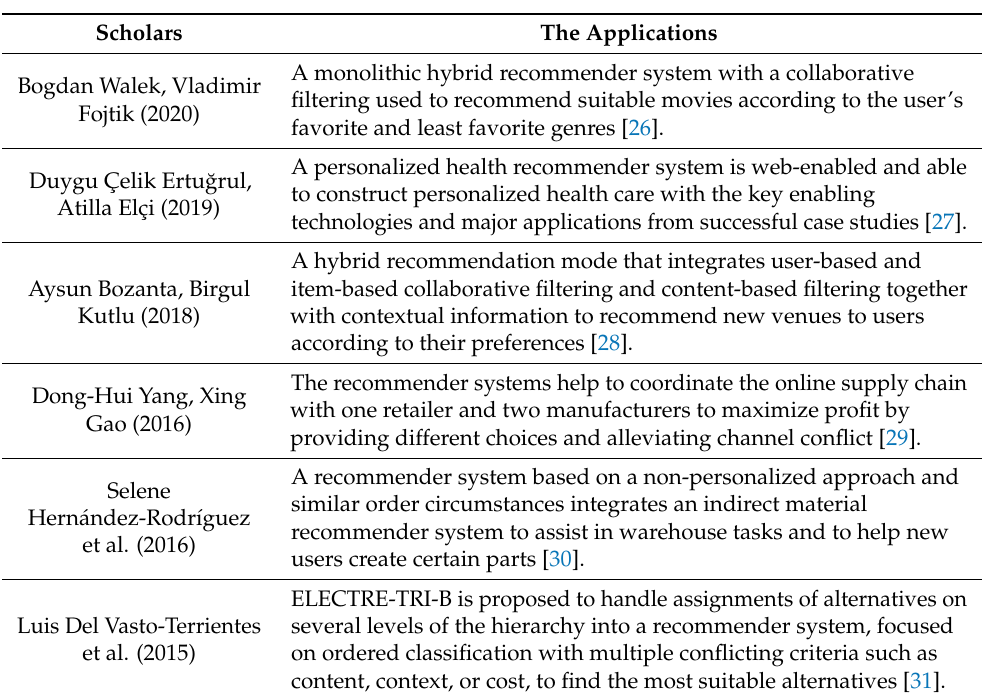
Table 1. The applications on recommendation systems.